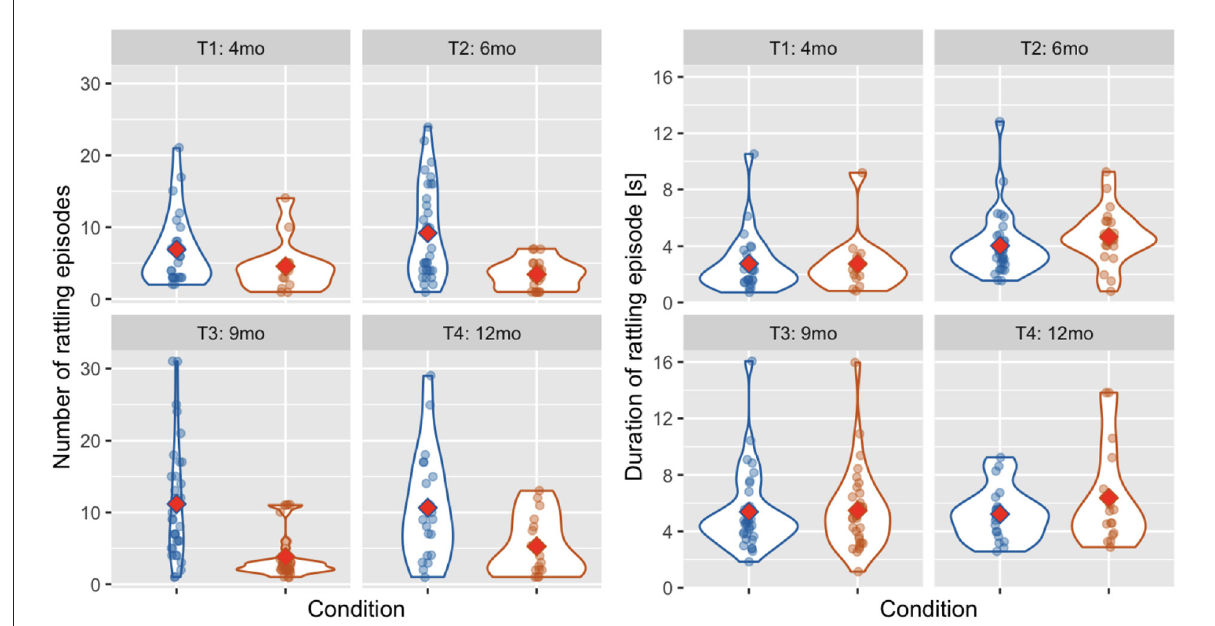
FIGURE6 Violin plots showing the number of rattling episodes (left) and the average duration of rattling episode (right) across time points and conditions: mother Not Providing Rhythm (blue) and Mother Providing Rhythm (orange). Red diamonds indicate mean values.